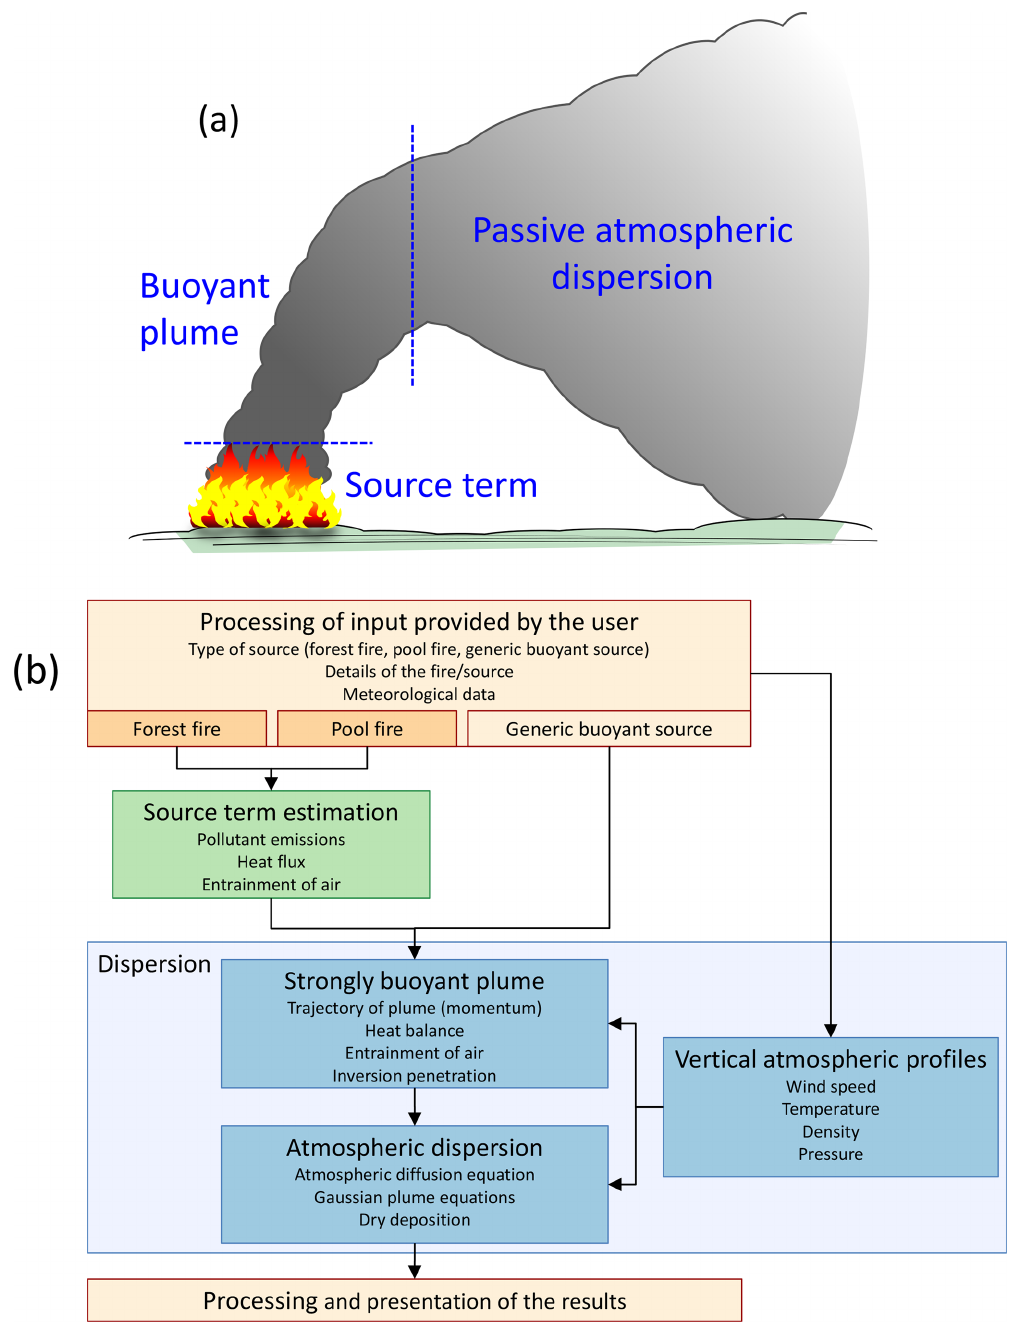
Figure 1. (a) A schematic presentation of the flow regimes of the dispersion of a fire plume. (b) A block diagram of the BUOYANT model.